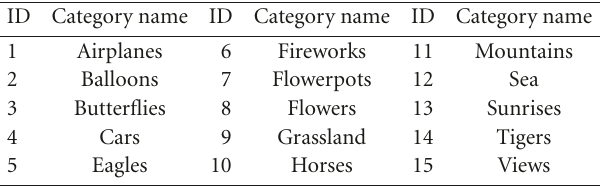
Table 1: Categories of the utilized experimental image